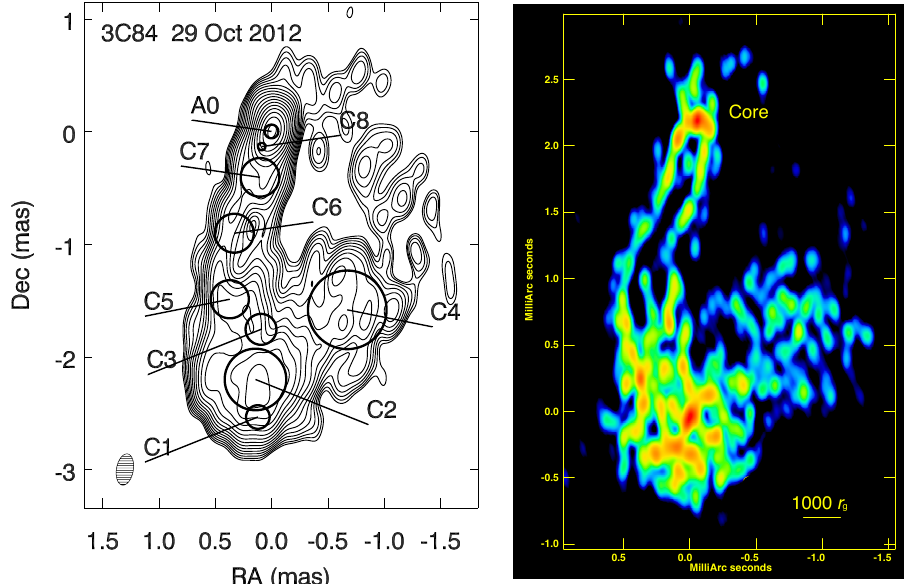
Figure 1. The left panel taken from [63] shows the total intensity image of NGC1275 at 43 GHz radio frequencies. The parsec-scale jet shows a complex structure and is dominated by two features: the core (A0) and a knot (C2). Knot C6 has the highest recorded proper motion of ∼ 0.36 c. The right panel taken from [67] shows the 22GHz space-VLBI image of NGC1275’s jet from the core to ∼ 1 pc. These high-resolution radio observations provide evidence of a limb-brightened jet. The large intensity ratio between the bright outer layer and the dim central region can be explained by transverse velocity structures and supports γ -ray emission scenarios via spine–sheath-structured jet